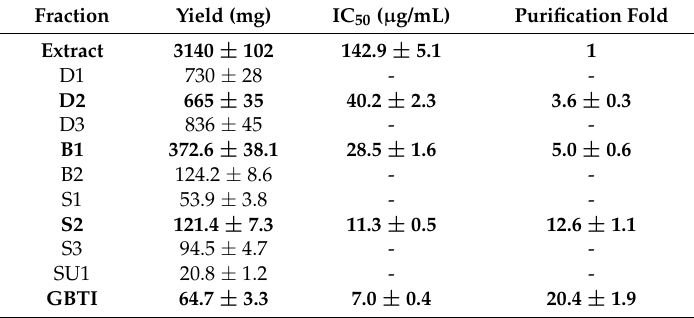
Trypsin inhibitor-enriched fractions are highlighted in boldface. Results represent mean ± SD, n =